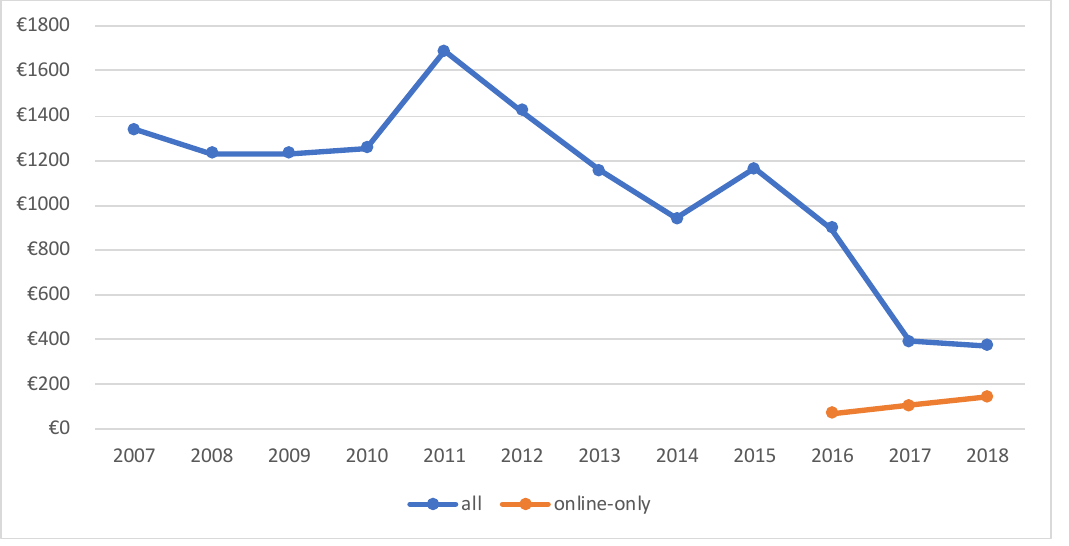
Figure 8. Average price of lots sold (2007 – 2018).